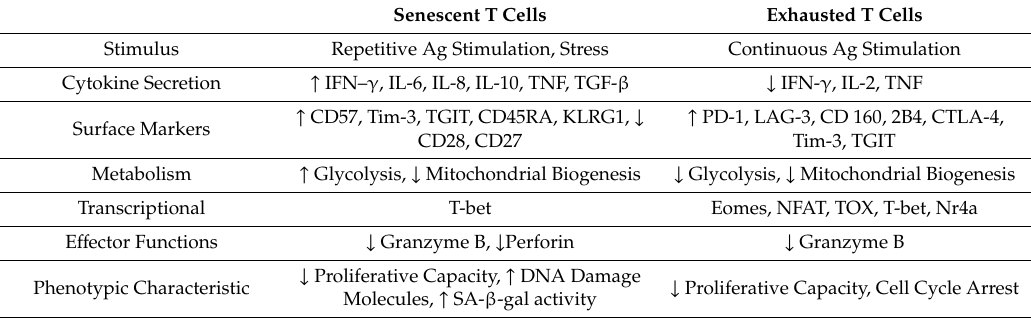
Table 1. Characteristics of senescent and exhausted T